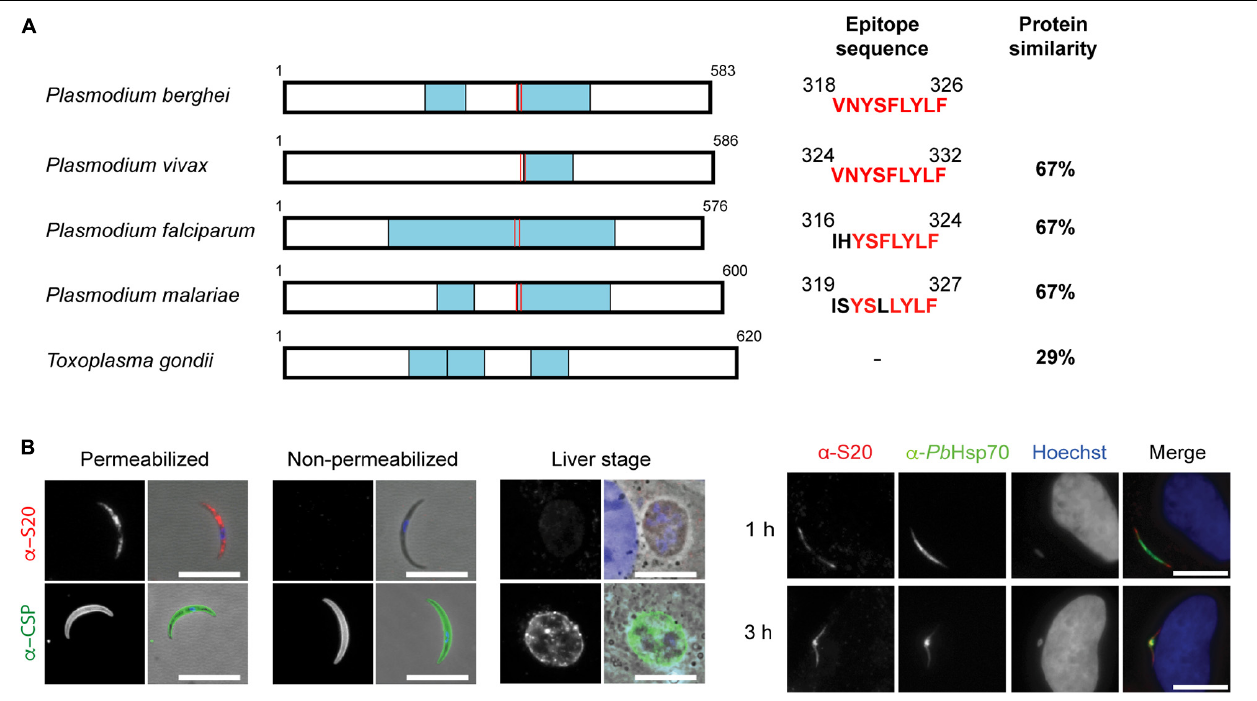
FIGURE 1 | Conservation and expression of Plasmodium berghei S20. (A) Primary structure of Plasmodium and Toxoplasma S20 proteins. Predicted Kelch domains are boxed in blue, and the position of the epitope is shown by red lines. P. berghei (PBANKA_1429200; XP_034424116.1), Plasmodium vivax (PVP01_1432200; XP_001617233.1), P. falciparum (PF3D7_1213400; XP_001350539.1), Plasmodium malariae (PmUG01_14048200; XP_028864377.1), and Toxoplasma gondii (TGGT1_229000; EPR64070). Accession numbers are according to EuPathDB (Aurrecoechea et al., 2017), and alignments were generated using the